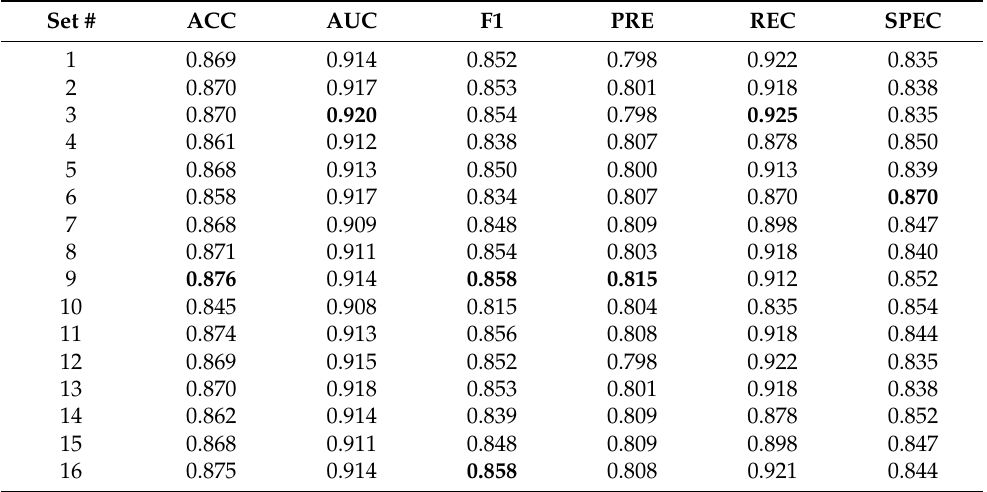
Table 3. Computational results for the TCGA dataset with the voting-based feature selection process.